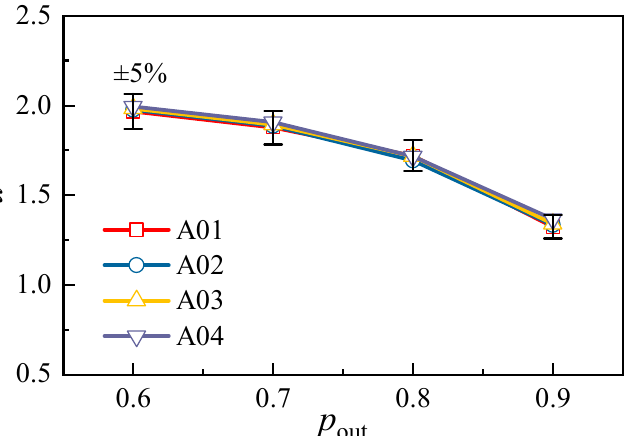
Figure 15. The influence of Reynolds number on the predicted values ( α = 25° and A VABI = 0.6).